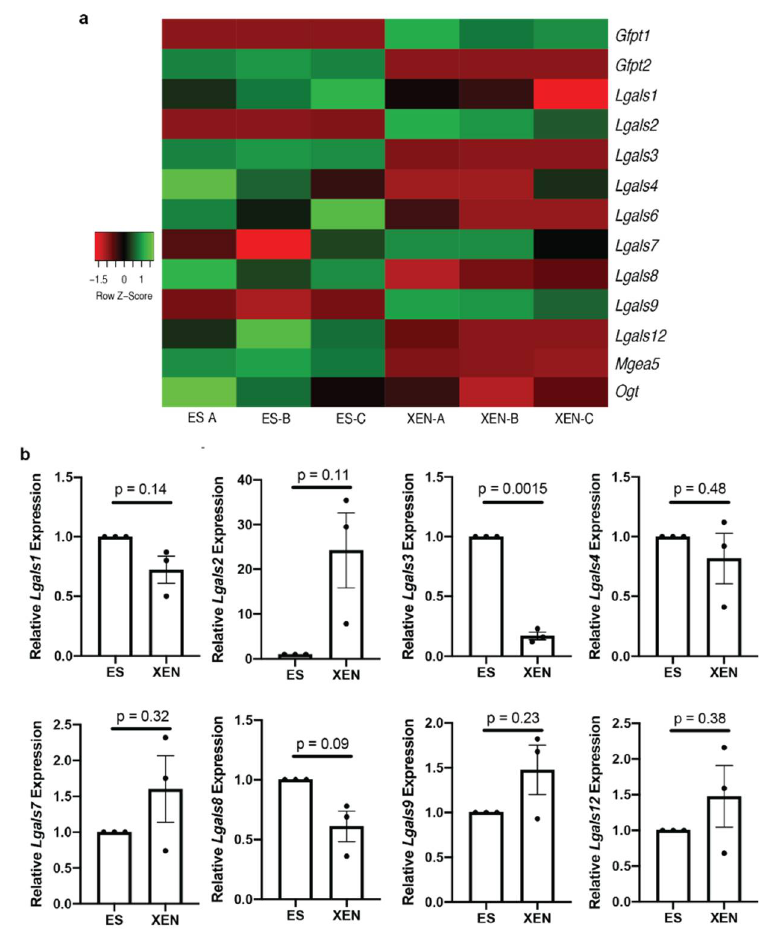
Figure 3. RNA sequencing and gene expression analysis of galectin genes in ES cells and XEN: ( a ) heat map of RNA sequencing of transcripts in ES cells and XEN showing Lgals genes 1–4, 7–9, and 12 and genes involved in O -GlcNAcylation Ogt , Mgea5 , Gfpt1, and Gfpt2 ; data are shown for 3 biological replicates denoted as -A, -B, and -C; ( b ) expression levels of Lgals1 , Lgals2 , Lgals3 , Lgals4 , Lgals7 , Lgals8 , Lgals9 , and Lgals12 as detected by RT-qPCR. Bars represent mean ± SEM, N =